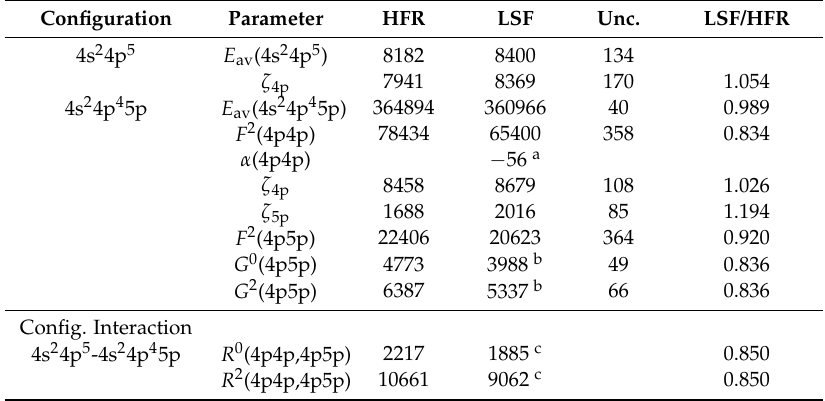
Table 4. Hartree-Fock and least–squares fitted parameters for the odd configurations of Y V. Mean error of fit 179 cm − 1